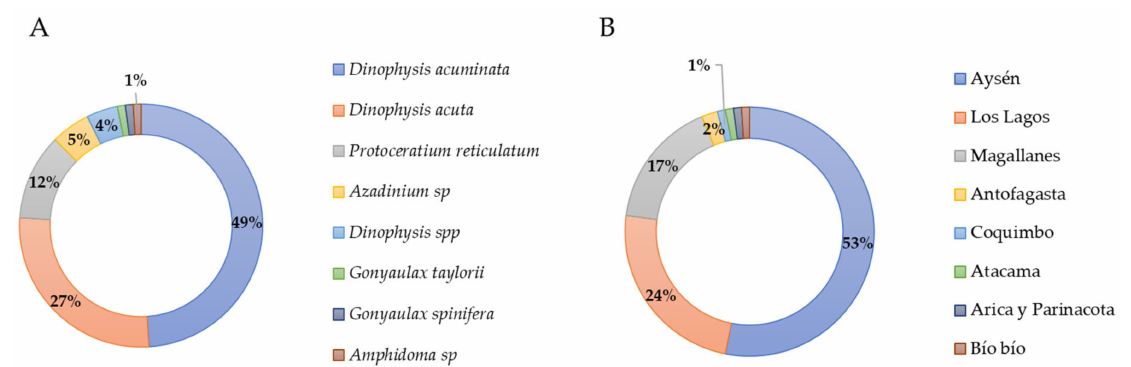
Figure 10. HABs events associated with lipophilic toxins in Chile, ( A ) distribution by species, ( B ) events by region of